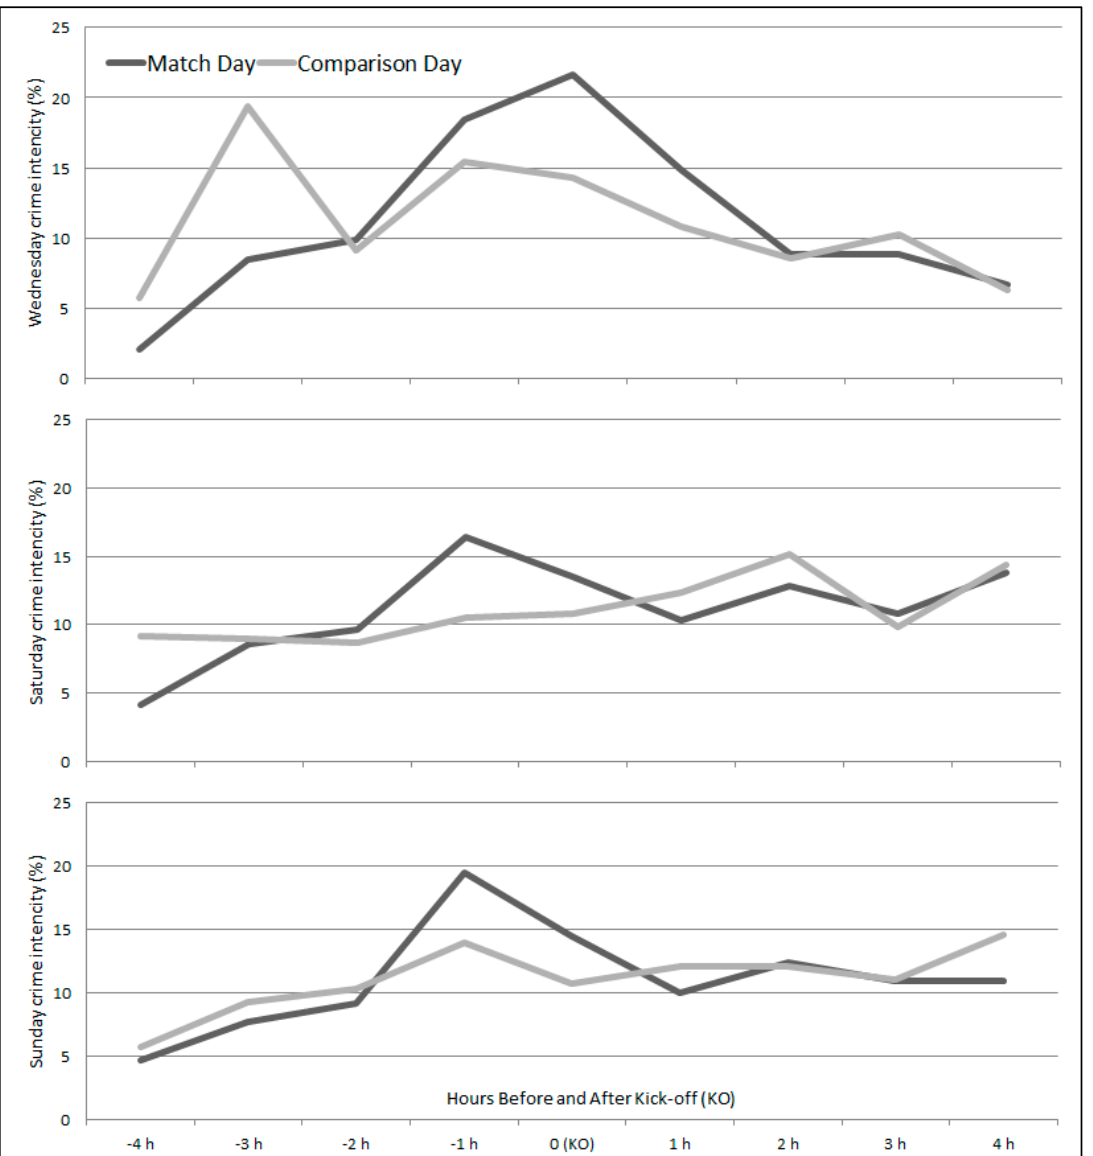
Figure 3. Crime intensity (normalized counts by percentage) per hour before and after the kick-off hour.